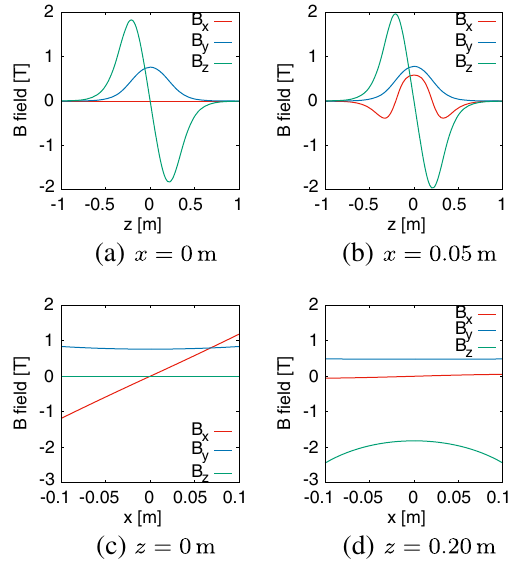
FIG. 1. B , B , and B fields along the longitudinal axis [(a) and x y z (b)] and the horizontal axis [(c) and (d)]. The center of the magnet is at x ¼ 0 , z ¼ 0 . In all cases, y ¼ 0 . The field profiles in (b) are shown off-midplane to demonstrate a nonzero horizontal field B . x The field profile in (d) is shown in the magnet end region to demonstrate a nonzero longitudinal field B . z